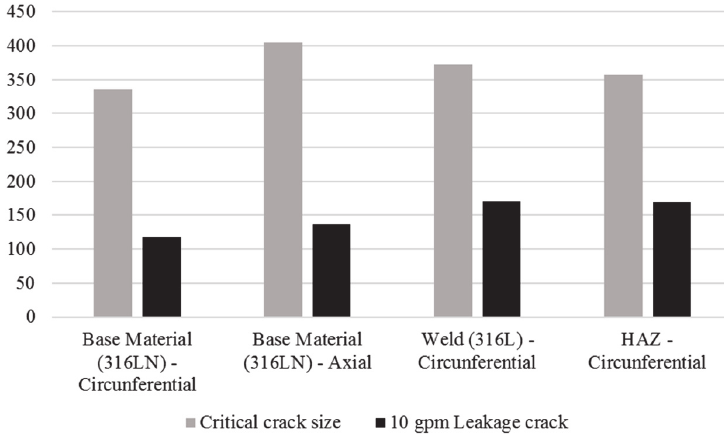
Figure 4: Average sizes for critical crack and 10 gpm leakage crack for different zones in welded